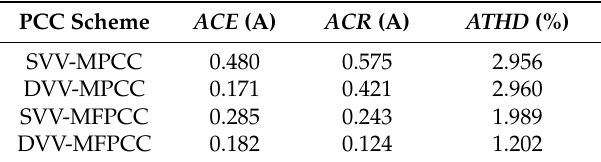
Table 8. ACE , ACR , and ATHD of the four schemes obtained from Figures 16–19.